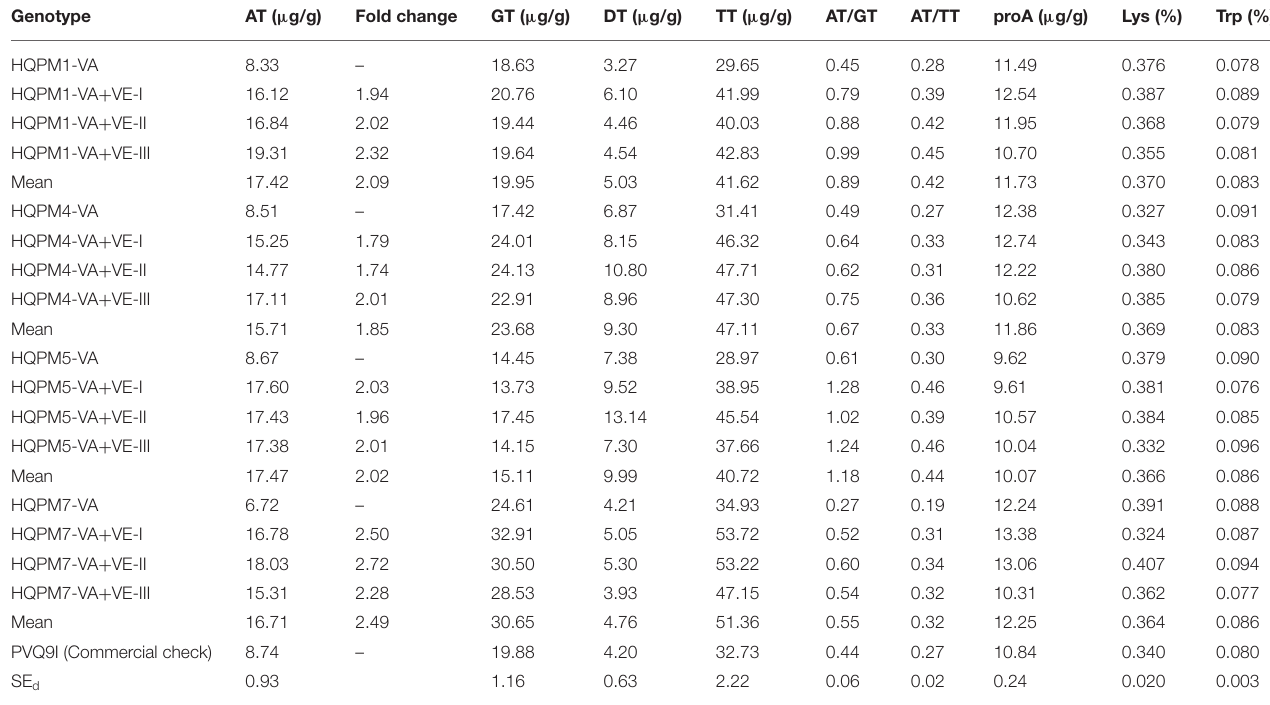
TABLE 4 | Mean performance of vte4 -derived reconstituted hybrids and their original hybrids for different quality parameters. Genotype AT ( µ